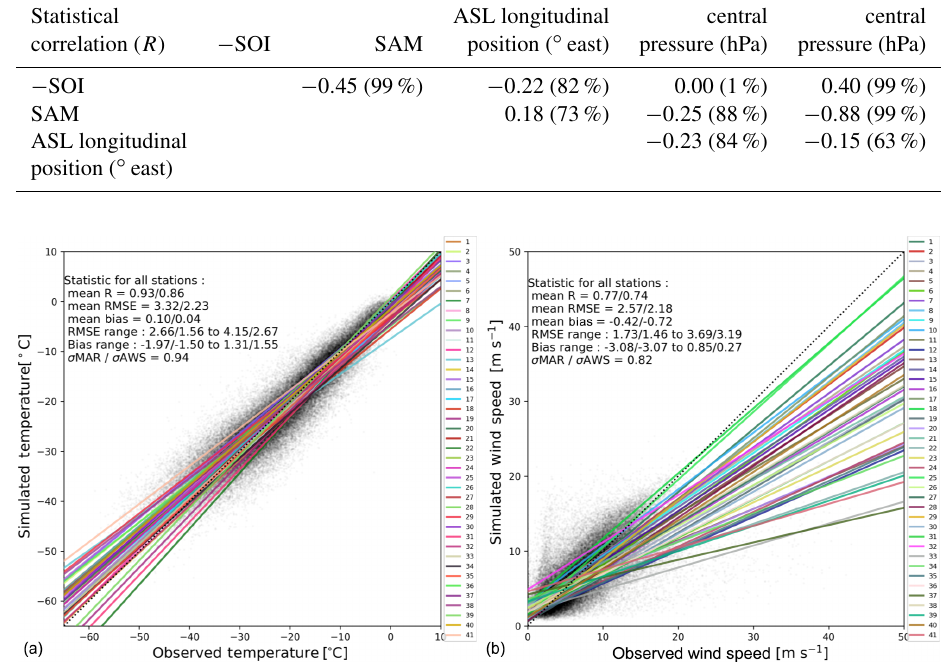
Figure 2. Scatter plots of observed vs. simulated daily near-surface temperature (a) and daily near-surface wind speed (b) for the selected AWSs (see corresponding locations and names in Fig. 1). The statistics, including RMSE, correlation ( R ), bias, and standard deviations ( σ ), are calculated for individual stations and provided as multi-station mean over the whole year and over the summer months (DJF). The range of RMSE and biases across individual stations is also indicated with the 10th percentile and the 90th percentile of all RMSE values. The lines represent least-mean-square linear fit between simulated data and observations. The complete statistical analyses for individual AWSs are provided in the Supplement (Tables S1–S2).